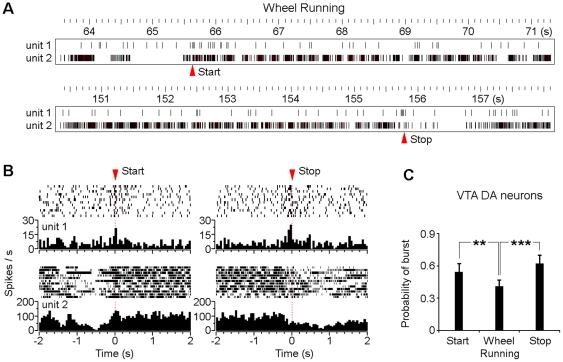
Burst activation of the VTA putative DA neuron at wheel running initiation/termination.(A) Rasters of two simultaneously recorded putative DA (unit 1) and non-DA (unit 2) neurons during voluntary wheel running. Red triangles indicate the start and stop of wheel running, respectively. It was noted that the two neurons were recorded from one tetrode in the VTA. (B) Peri-event rasters and histograms of the same two neurons (as shown in A) referenced to the starts (left panels) and stops (right panels) of wheel running. (C) VTA putative DA neurons exhibit significant higher probability of burst activity at starts and stops of wheel running in compare with the sustained wheel running. (n  =  14; **P < 0.01, ***P < 0.001, Student's paired t-test). Error bars represent s.e.m.